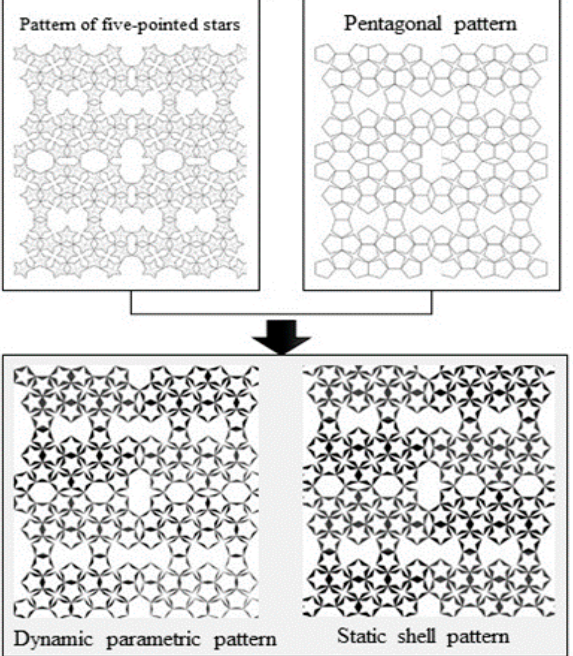
Figure 1. The process of forming a fixed and dynamic shading pattern.